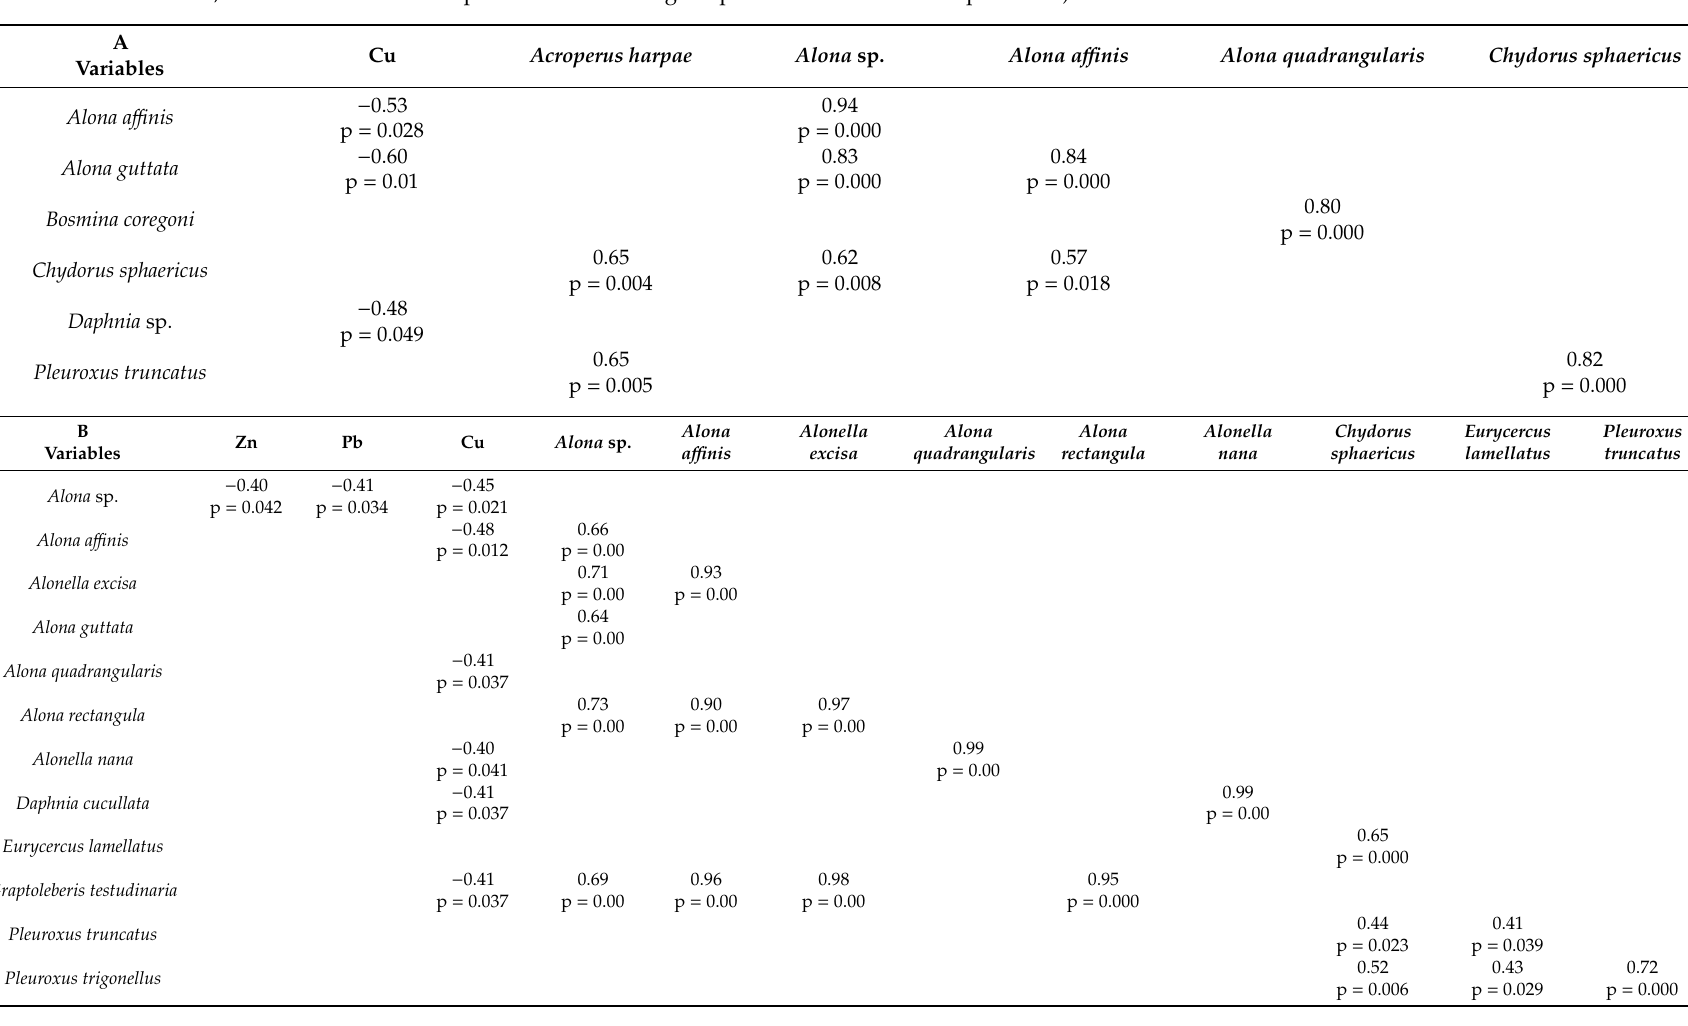
Table 3. Pearson’s correlation—significant relationships between heavy metals concentrations and density of Cladocera (A: UP—subsidence ponds formed after the closure of the mine; B: DOWN—subsidence ponds created during the peak of Zn and Pb ore